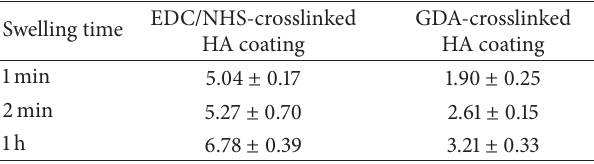
Table 2: Water uptake of EDC/NHS- and GDA-crosslinked HA coatings ( 𝑛 = 3 ) after different swelling times in 1mL PBS/Tween 20. Data shown in mg water per mg coating as mean ±